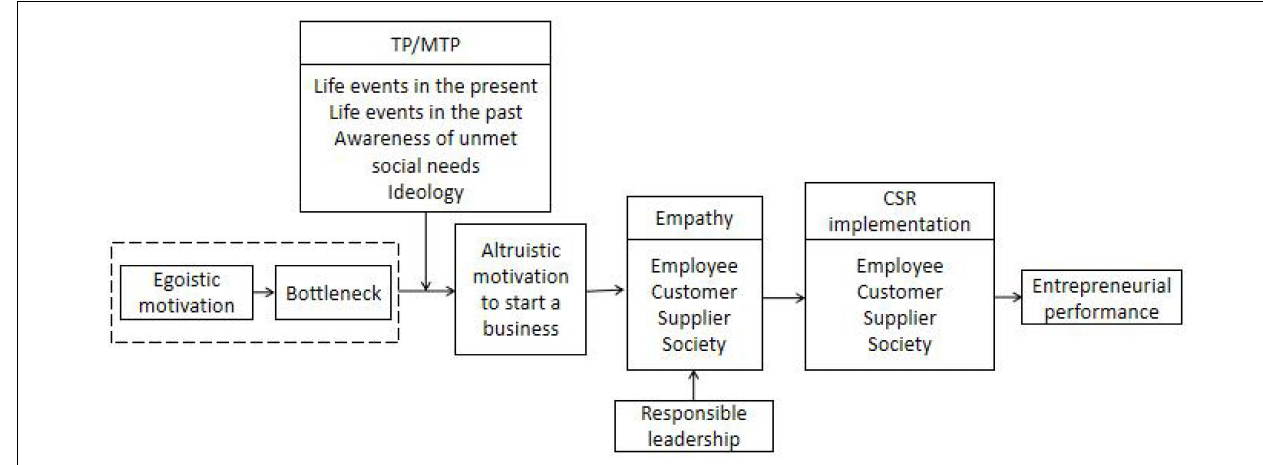
FIGURE 2 | Entrepreneurial motivation evolution process model of Chinese